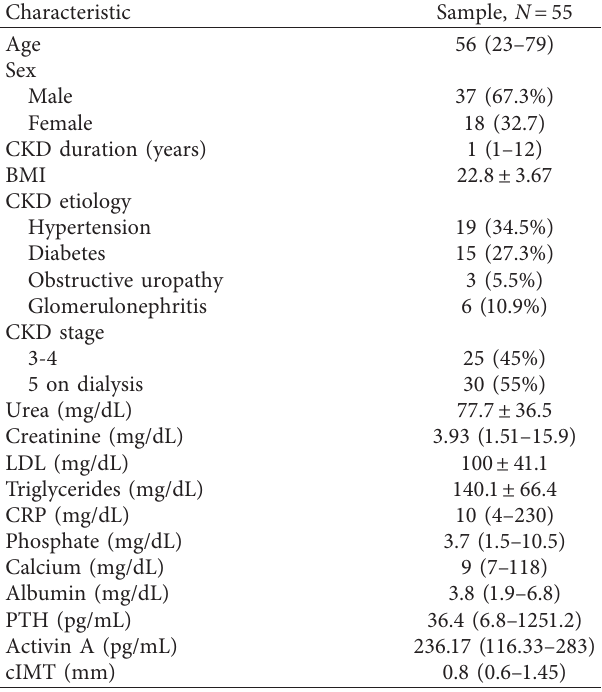
Table 1: Demographic and clinical characteristics of the study population.